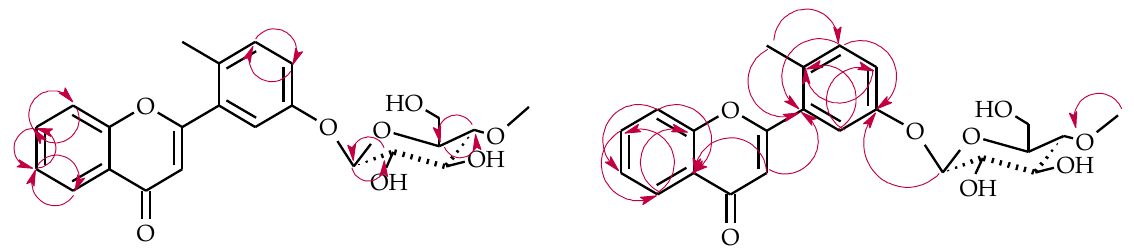
Table 3. 1 H- NMR chemical shifts δ (ppm) and coupling constants J (Hz) of 2′ -methylflavone ( 5 ) and products of its biotransformations 5a – 5c in Acetone-d6, 600 MHz (Supplementary Materials: Fig- ures S106, S120, S136,